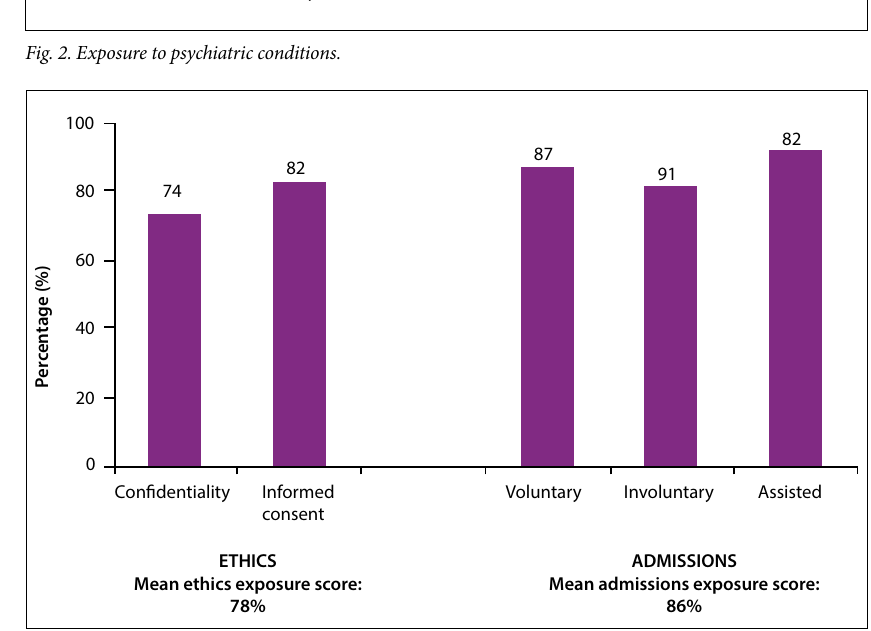
Fig. 5 summarises the aggregated scores for male and female respondents for the four scales that were created. None of these scores demonstrated a significant difference between the two groups. Females